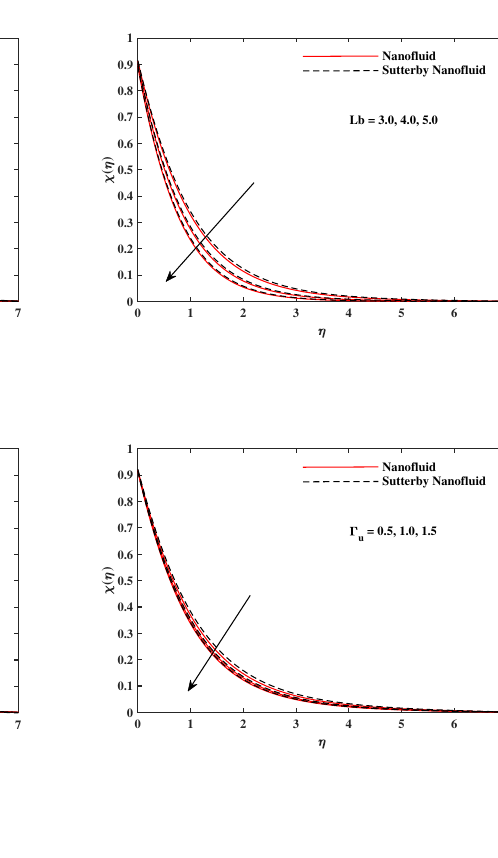
Figure 13. φ ( η ) fluctuate with Γ u , Γ v , and Γ C .